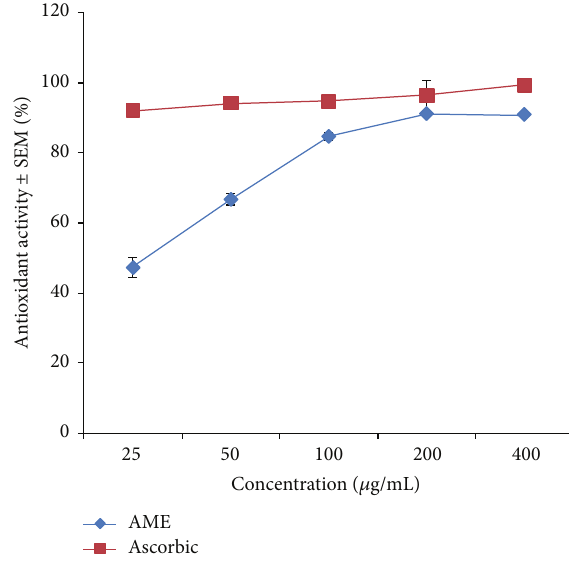
Figure 1: The in vitro antioxidant activity of AME using DPPH photometric